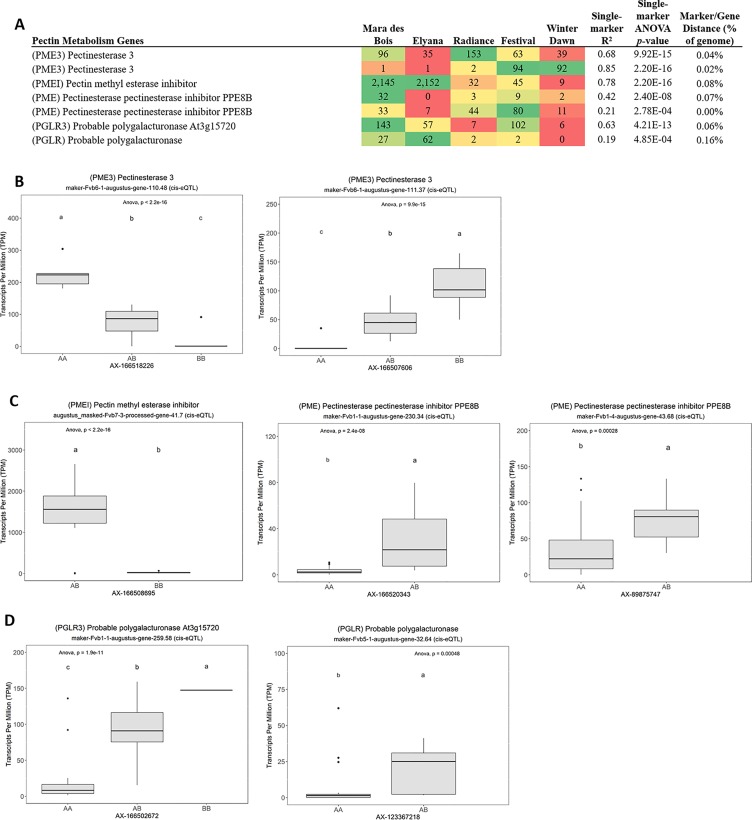
eQTL pertaining to strawberry pectin metabolism. (A) Transcript accumulation in parental lines, GWAS-derived FDR p values and narrow-sense heritability estimates, single-marker R2 and p values are shown. Phenotype distributions based on allelic state are shown for (B) pectin esterases, (C) pectin esterase inhibitors, and (D) polygalacturonases. Letters represent statistically separable means via Tukey’s HSD post hoc test (p < 0.05).